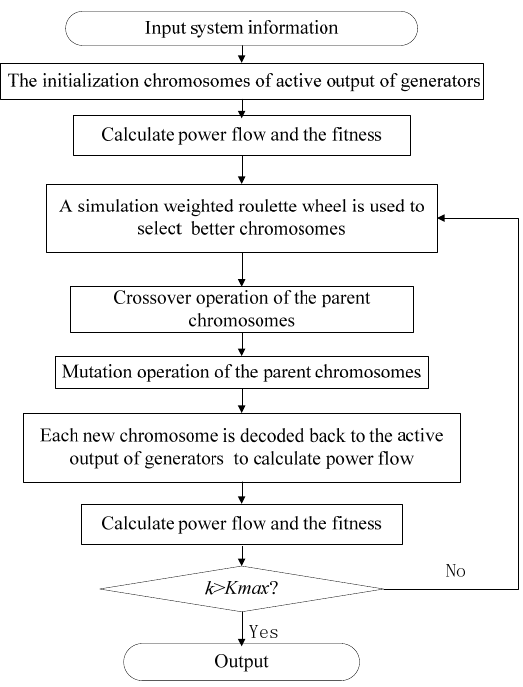
Figure 1. The flowchart of genetic algorithm.